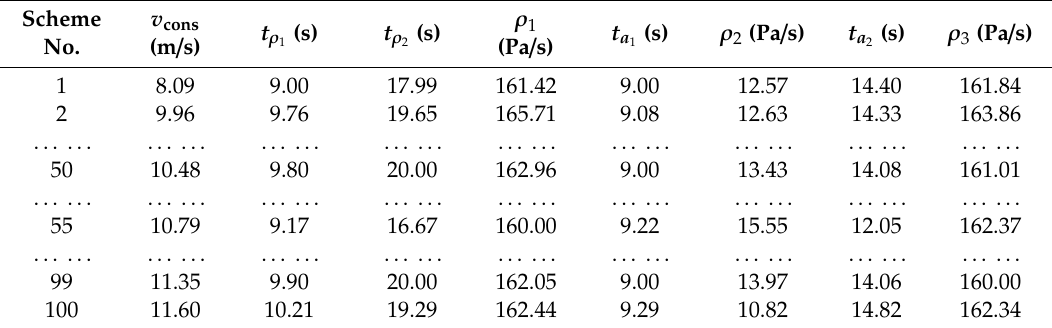
Table 2. Optimal solution set for 32th-generation o ff spring.